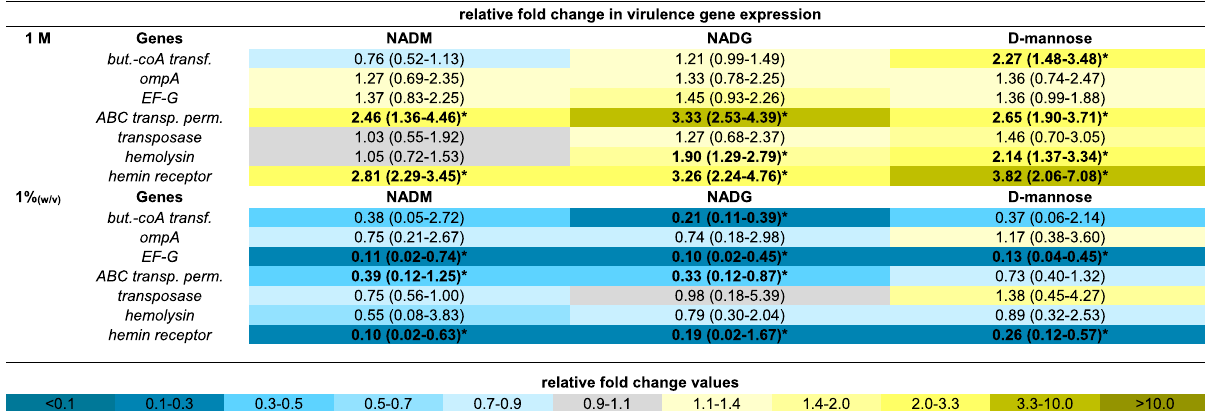
Table 3. Comparison of the effects of repeated multi-species biofilm rinsing with NADM, NADG or d-(+)-mannose on F. nucleatum virulence gene expression. Fold changes in virulence gene expression were determined relative to the control condition through the 2 −ΔΔCt method and are shown as the geometric mean (C.I.) (n = 3) of the 2 −ΔΔCt values. All substrates were dissolved in PBS at 1 M (upper part) or ~ 0.05 M (1% (w/v) ) (lower part) (0.045 M (NADM and NADG) and 0.056 M (d-(+)-mannose)). Values between 0 and 1 represent relative downregulation, values > 1 represent relative upregulation. Statistically significantly different fold changes relative to the control (PBS) that are < 0.5 (> twofold downregulated) or > 1.5 (> 1.5-fold upregulated) are considered biologically relevant and are shown in bold and marked with ‘ * ’ ( P < 0.05, ANOVA + Dunnett’s correction for simultaneous hypothesis testing). For such values, statistically significant differences between two treatment conditions are marked with ‘ #1 ’ (vs. NADM), ‘ #2 ’ (vs. NADG), ‘ #3 ’ (vs. d-(+)-mannose) and shown in bold ( P < 0.05, ANOVA + Tukey’s correction for simultaneous hypothesis testing for comparisons between 3 substrates, unpaired two-tailed t-test for comparisons between 2 substrates). Statistically significantly different values between treatment conditions were only considered relevant if each condition was also significantly different from the control condition and only such differences are indicated. Color code: magnitude of the fold change in gene expression relative to the control. NADM: N -acetyl-d-mannosamine; NADG: N -acetyl-d- glucosamine; C.I.: 95% confidence interval; but.-coA transf.: butyrate-acetoacetate CoA transferase; ABC transp. perm.: ABC transporter